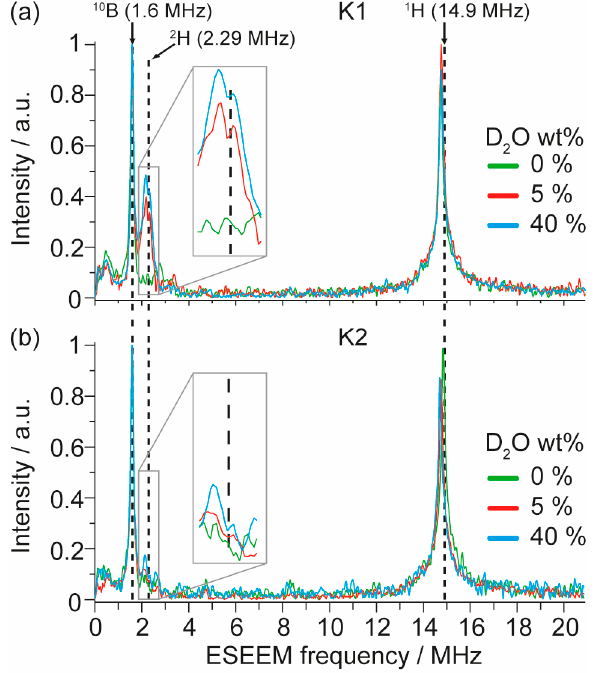
Figure 1. Three-pulse ESEEM spectra detected for K1 ( a ) and K2 ( b ) probes dissolved in various D 2 O/[Bmim]BF 4 mixtures (indicated in legend). All spectra are normalized to 10 B signal intensity.